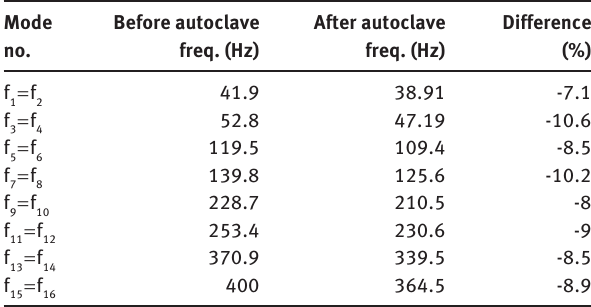
Table 11: Comparison between experimental natural frequencies of truncated cone # 2 (before and after autoclave).